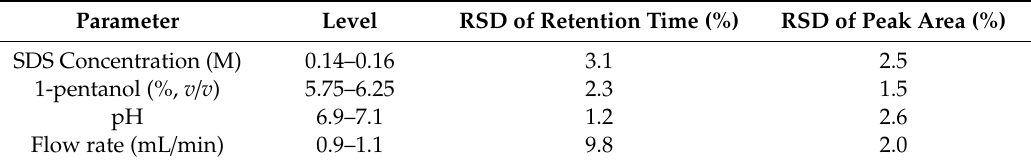
Table 1. Robustness study of the developed method (RSD, relative standard